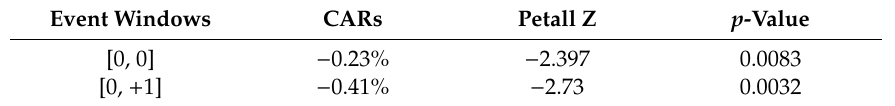
Table 5. Cumulative abnormal returns (CARs) results by short-term (value-weighted